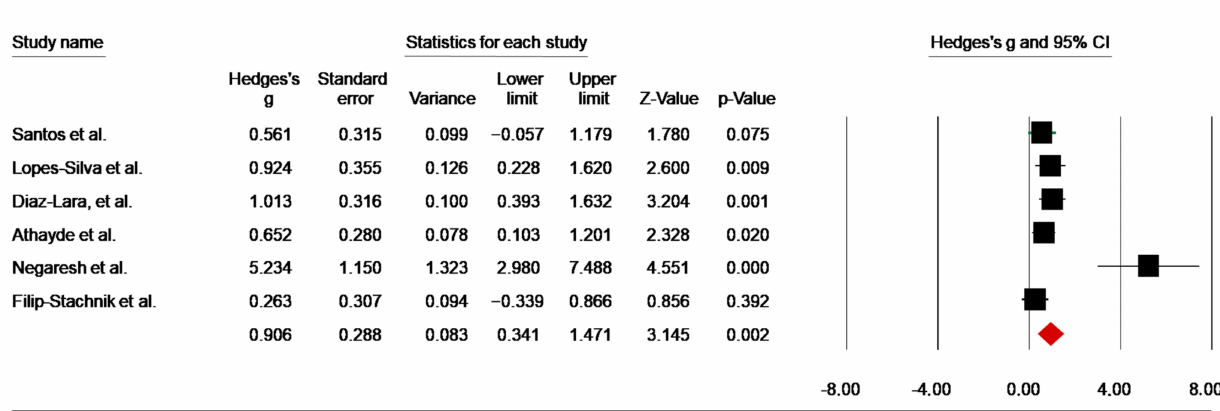
Figure 8. Forest plot of the effect of caffeine intake on [La] post-combat [46,49,51,54,66,67]. Effects of Caffeine Supplementation on Heart Rate Responses